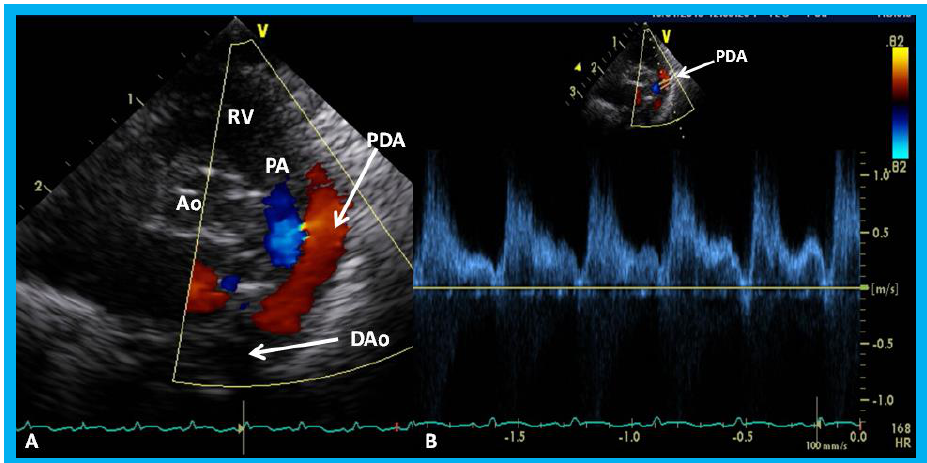
Figure 32. Parasternal short axis echo-Doppler imaging ( A ) demonstrating patent ductus arteriosus (PDA) with left-to-right shunt and high Doppler flow velocity ( B ) across the PDA suggestive of normal/low pulmonary artery pressure. Ao, aorta; D, diastolic; DAo, descending aorta; RV, right ventricle; S, systolic.